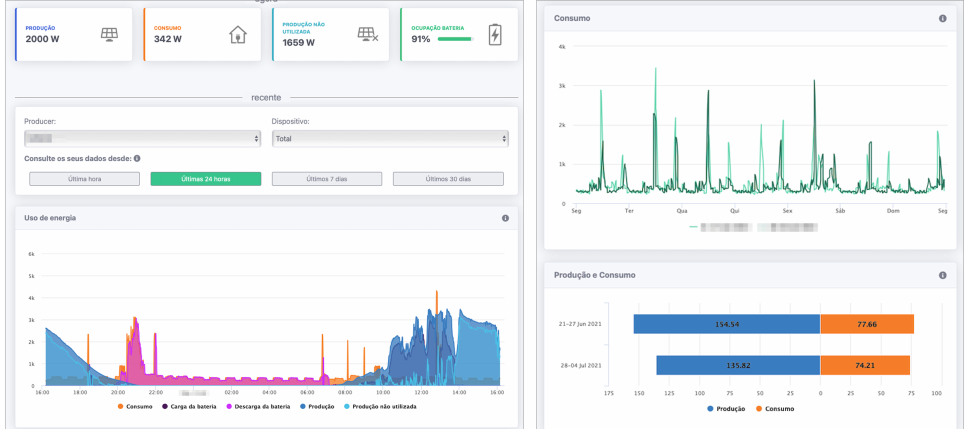
Figure 4. User interface of the ESB. Left : main screen of the web application showing the real-time electricity production, consumption, and a graph with the 24 h; Right : Comparison screen from the web application, comparing the consumption by